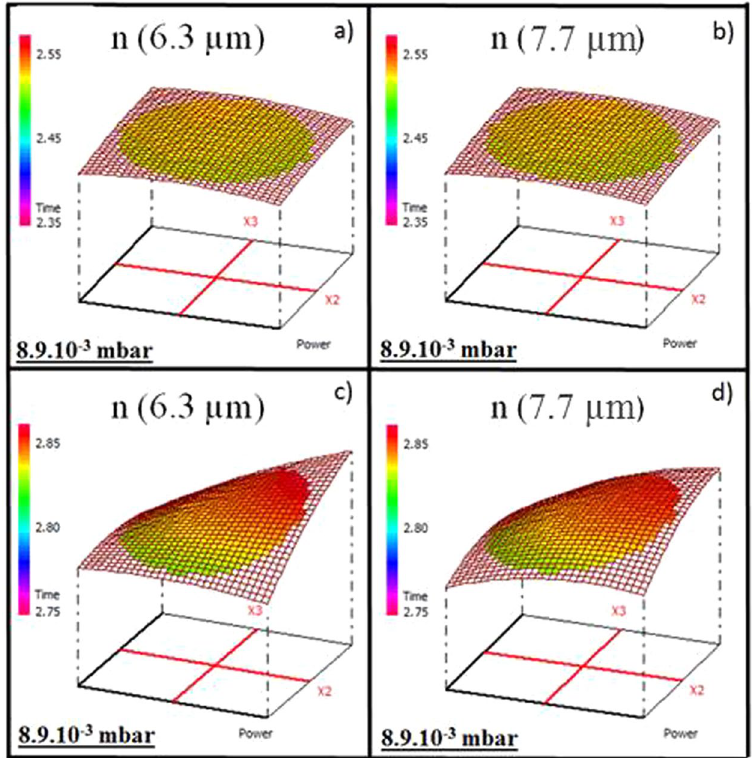
Figure 4. Variation of the refractive index of the thin films for a fixed Ar pressure ( a ) Ge 28.1 Sb 6.3 Se 65.6 , λ = 6.3 µ m, ( b ) Ge λ = 7.7 µ m, ( c ) Ge λ = 6.3 µ m, ( d ) Ge λ = 7.7 µ 28.1 Sb 6.3 Se 65.6 , 12.5 Sb 25 Se 62.5 , 12.5 Sb 25 Se 62.5 ,